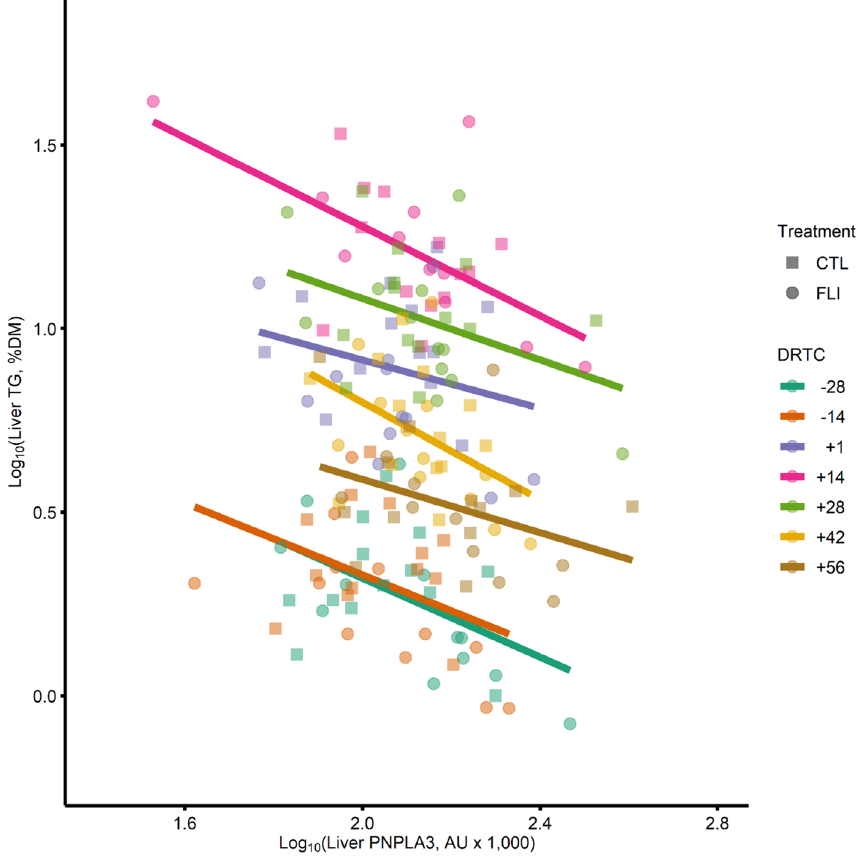
Figure 5. A representative plot for mixed effect regression analysis associating liver patatin-like phospholipase domain-containing protein 3 (PNPLA3) to liver triglyceride (TG) content. Liver PNPLA3 was negatively associated (β = − 0.31; P = 0.03) with liver TG when controlling for experimental design factors, including treatment, days relative to calving (DRTC), the interaction of treatment and time, and block effects. Magnitude of liver PNPLA3 abundance effect on liver TG content is represented by trendlines for the linear predictor within